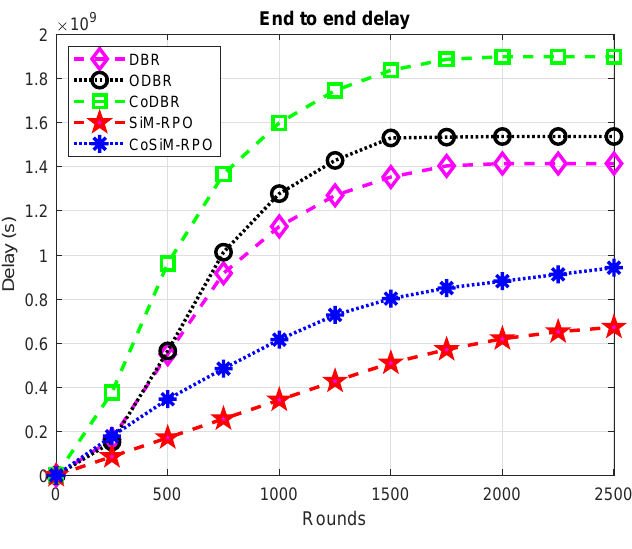
Figure 12. Latency of the